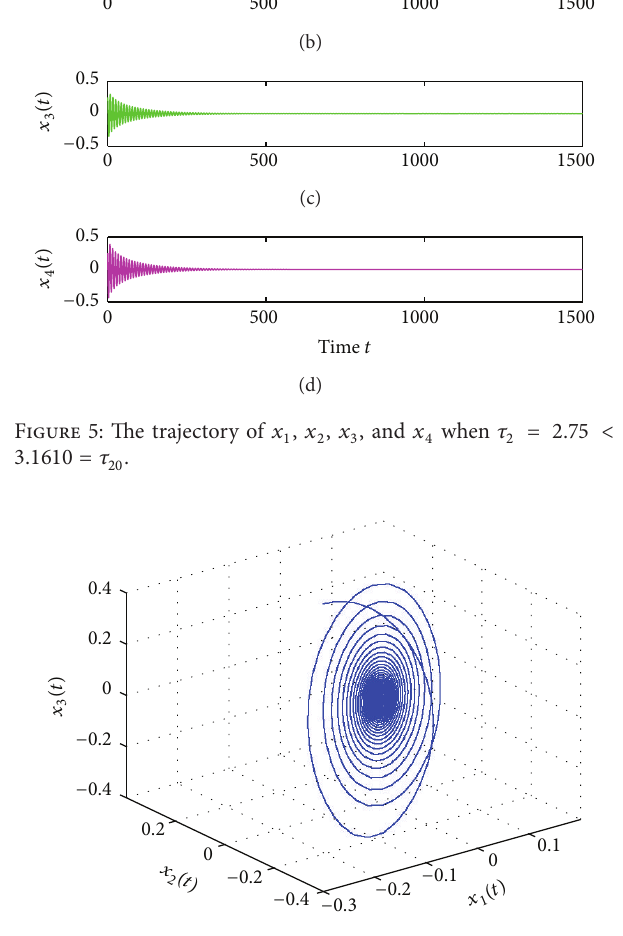
Figure6:Thephaseplotof 𝑥 1 , 𝑥 2 ,and 𝑥 3 when 𝜏 2 = 2.75 < 3.1610 = 𝜏 20 .